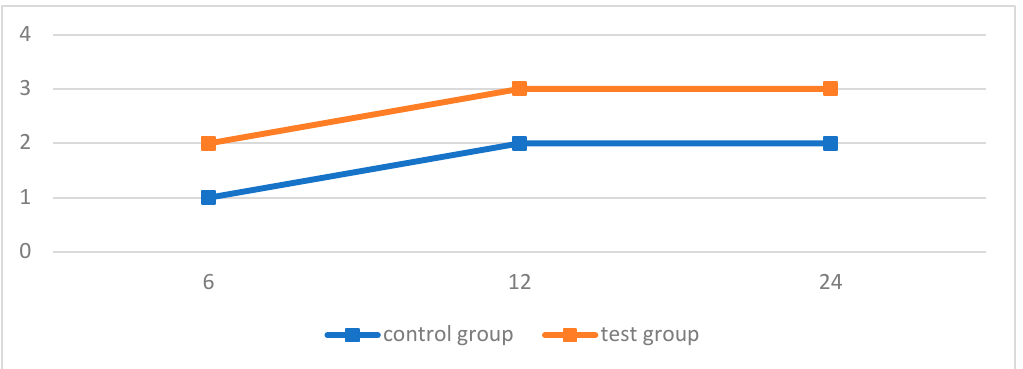
Figure 4. Marginal discoloration within both groups.